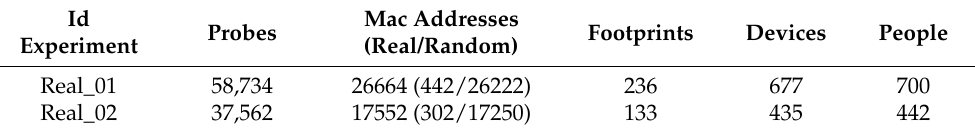
Table 5. Validation experiments’